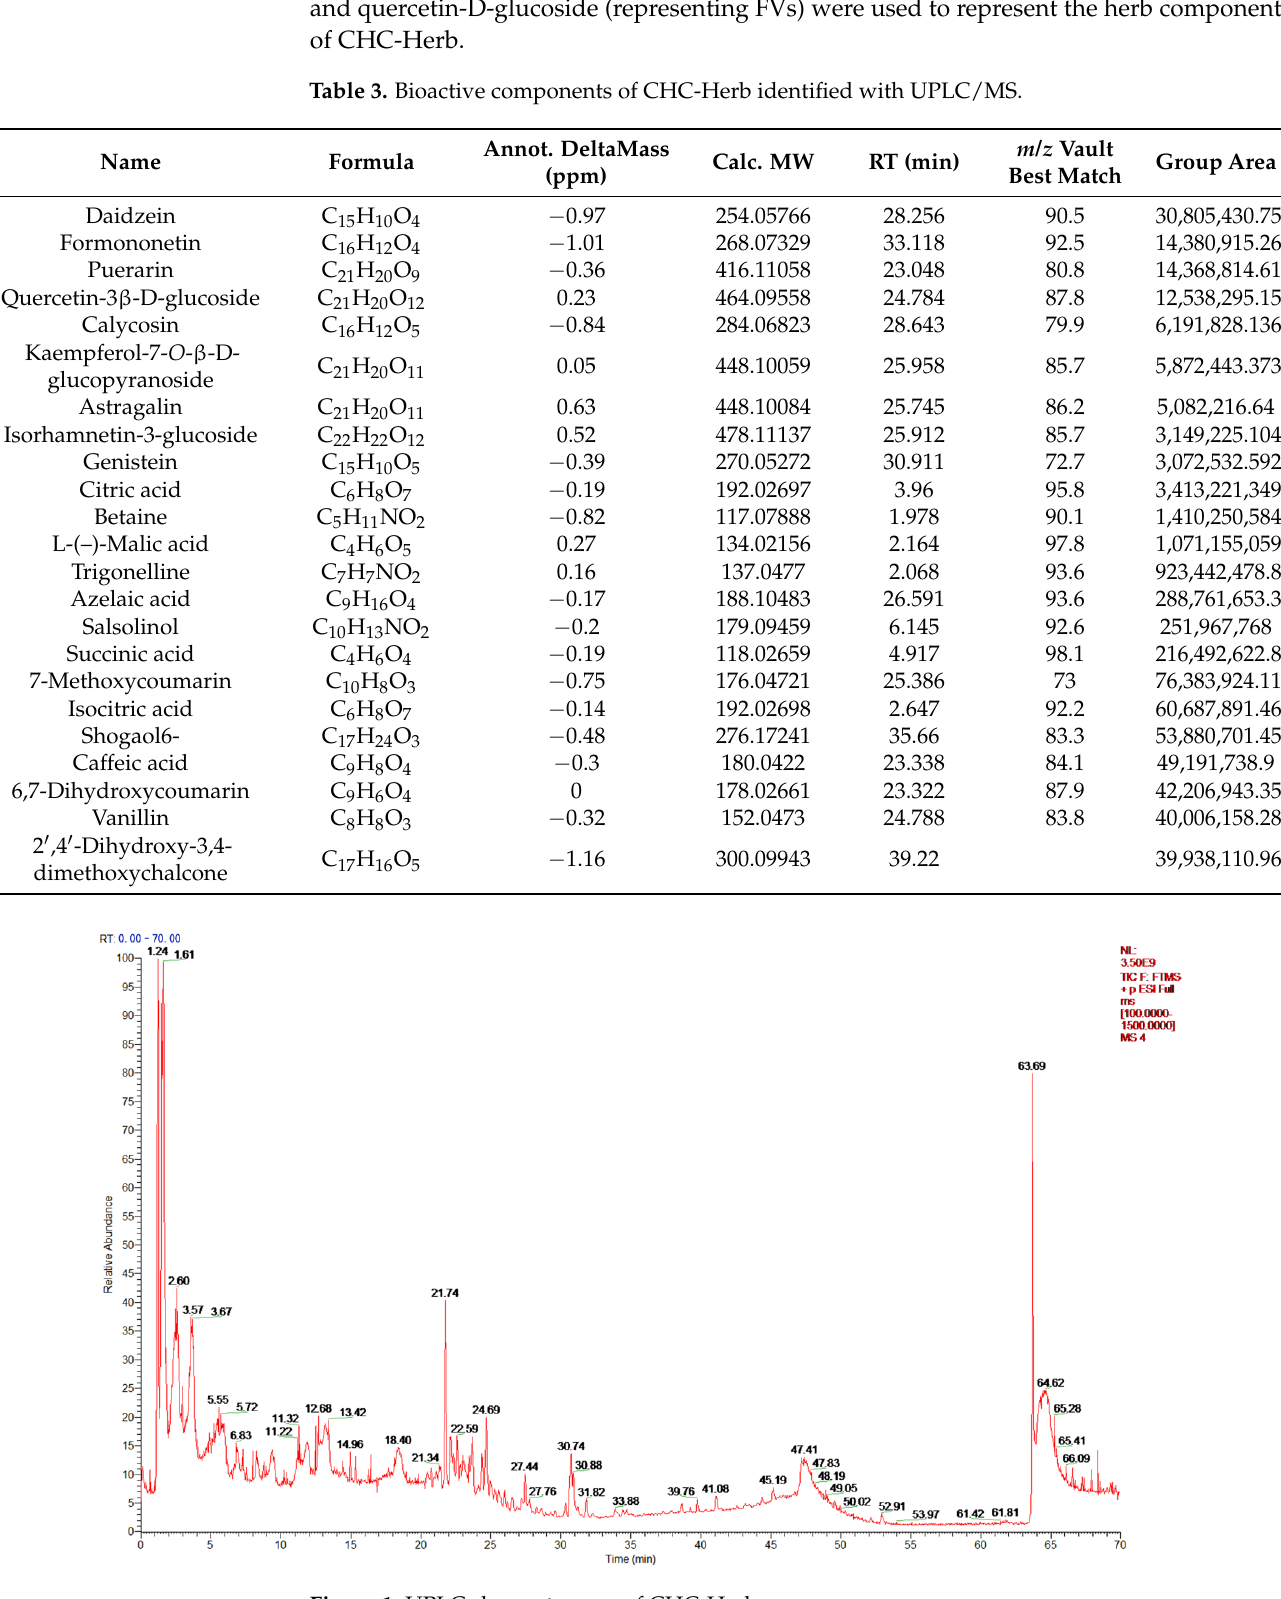
Figure 1. UPLC chromatogram of CHC-Herb.